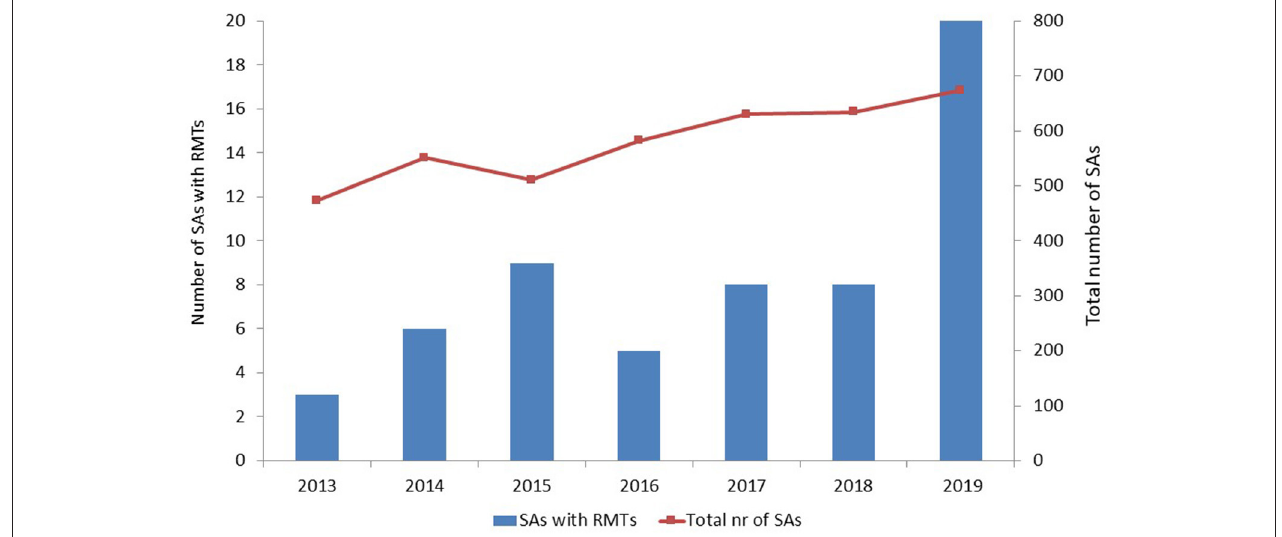
FIGURE 1 | Number of scientific advices that included remote monitoring technologies and total number of scientific advices per year. SAs, scientific advices; RMTs, remote monitoring technologies.